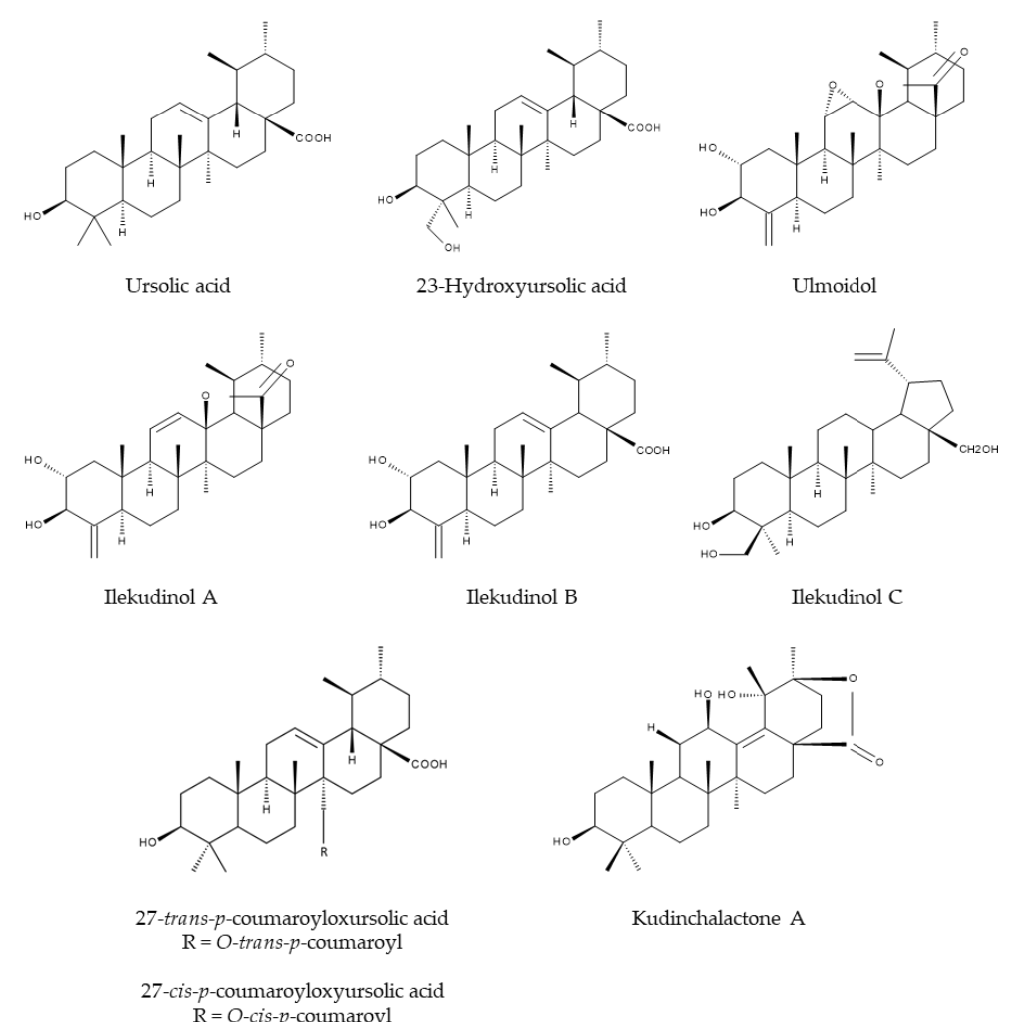
Figure 4. Chemical structures of the triterpenoids in Kuding tea.